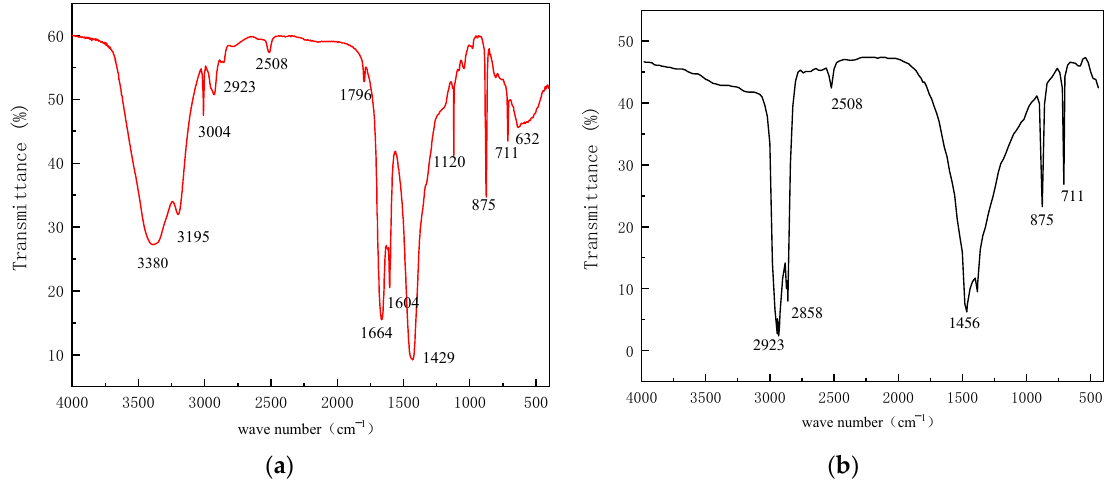
Figure 3. The FTIR analysis results. ( a ) PAASM-CaCO 3 ; ( b ) NCC.